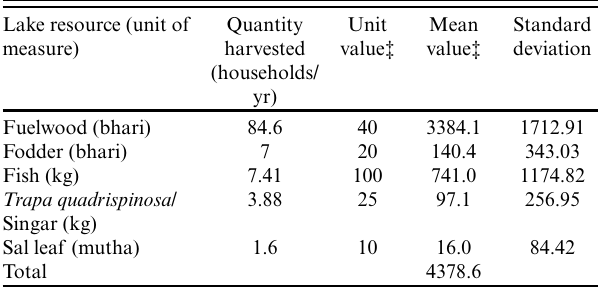
Table 3. Monetary value of lake resources extracted by the sampled